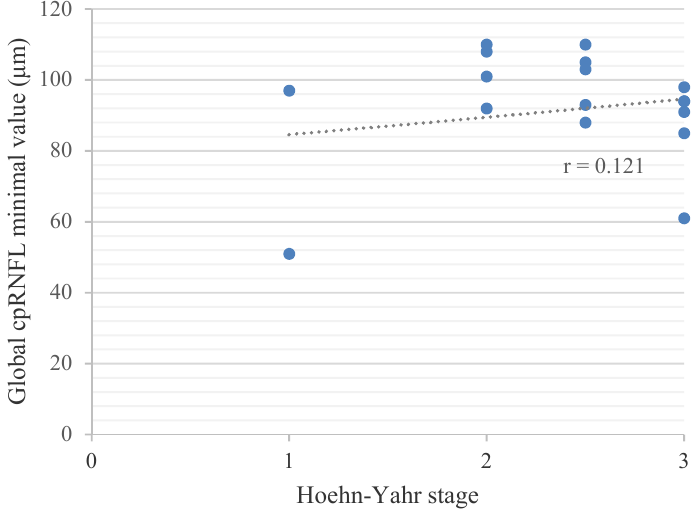
Figure 2. Pearson’s Correlation between the Hoehn − Yahr stage and the Global cpRNFL Value.